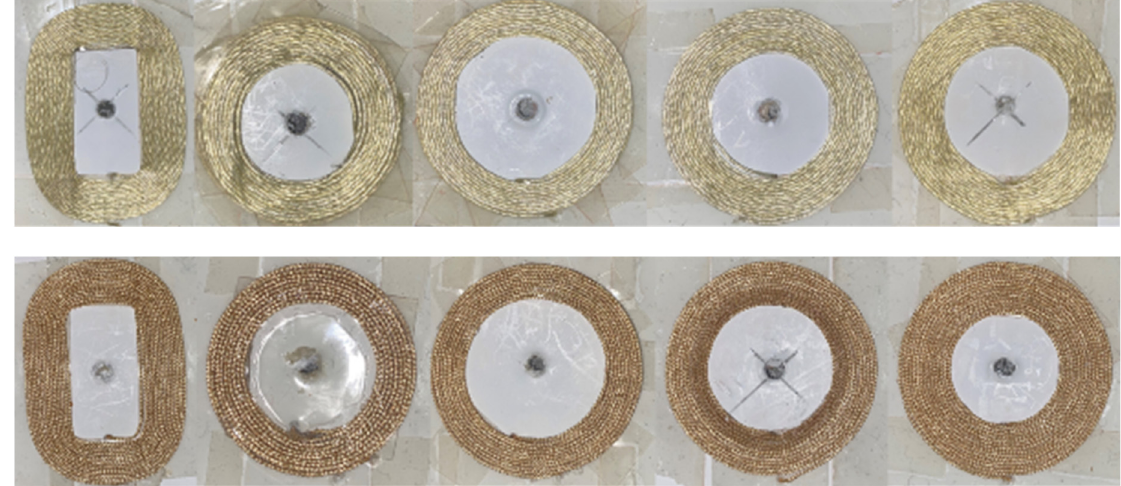
Figure 5. Wound coils according to the Qi standard with ELITEX and wrapping yarn: WPR1E, WPR2E, WPR3E, WPR4E, WPR5E, (upper row from left to right) WPR1U, WPR2U, WPR3U, WPR4U, and WPR5U (bottom row from left to right).